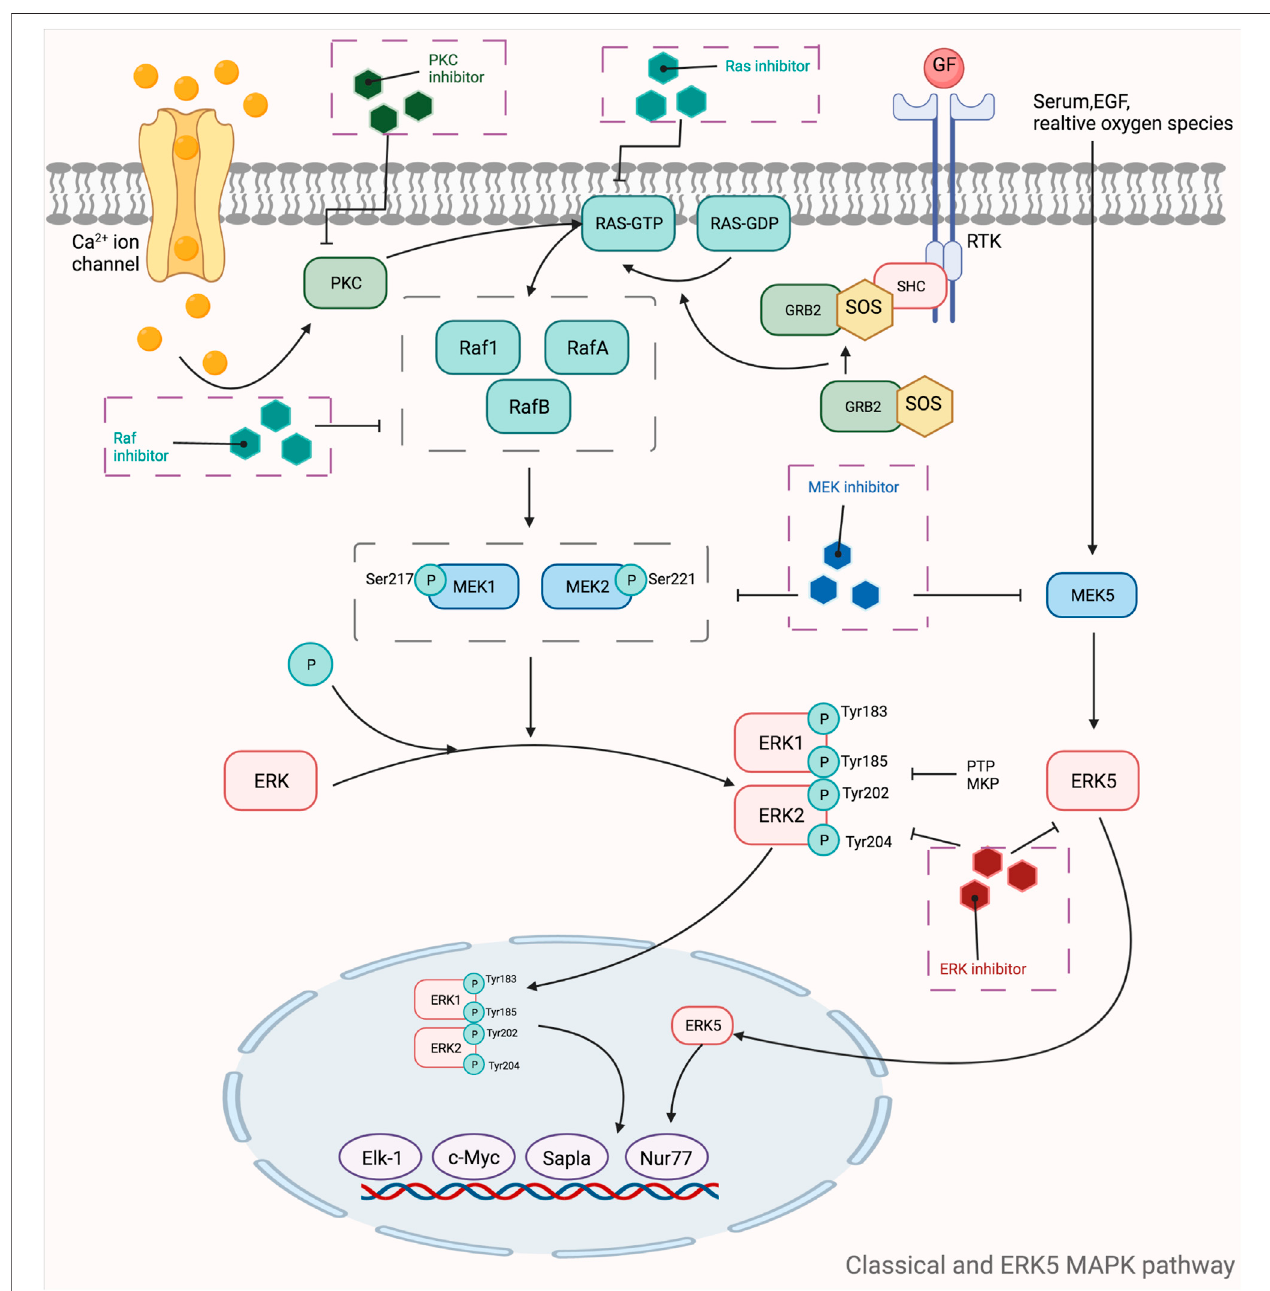
FIGURE 5 | Mechanistic map of the classical and ERK5 MAPK signaling pathway. c-Myc, cell-myc; EGF, epidermal growth factor; Elk-1, ETS domain-containing proteinElk-1;ERK, extracellularregulatedprotein kinases; GDP,guanosine diphosphate; GTP,guanosinetriphosphate; GRB2,growth factorreceptor-boundprotein 2; MEK,mitogen-activated protein kinase kinase; MKP, mitogen-activated protein kinase phosphatase1; Nur77, nerve growthfactor-induced gene B; PKC, protein kinase C; PTP, protein tyrosine phosphatase; Ras, rennin angiotensin system; RTK, receptor tyrosine kinases; SHC, Src homology 2 domain containing; SOS, son of sevenless The fi gure is created with